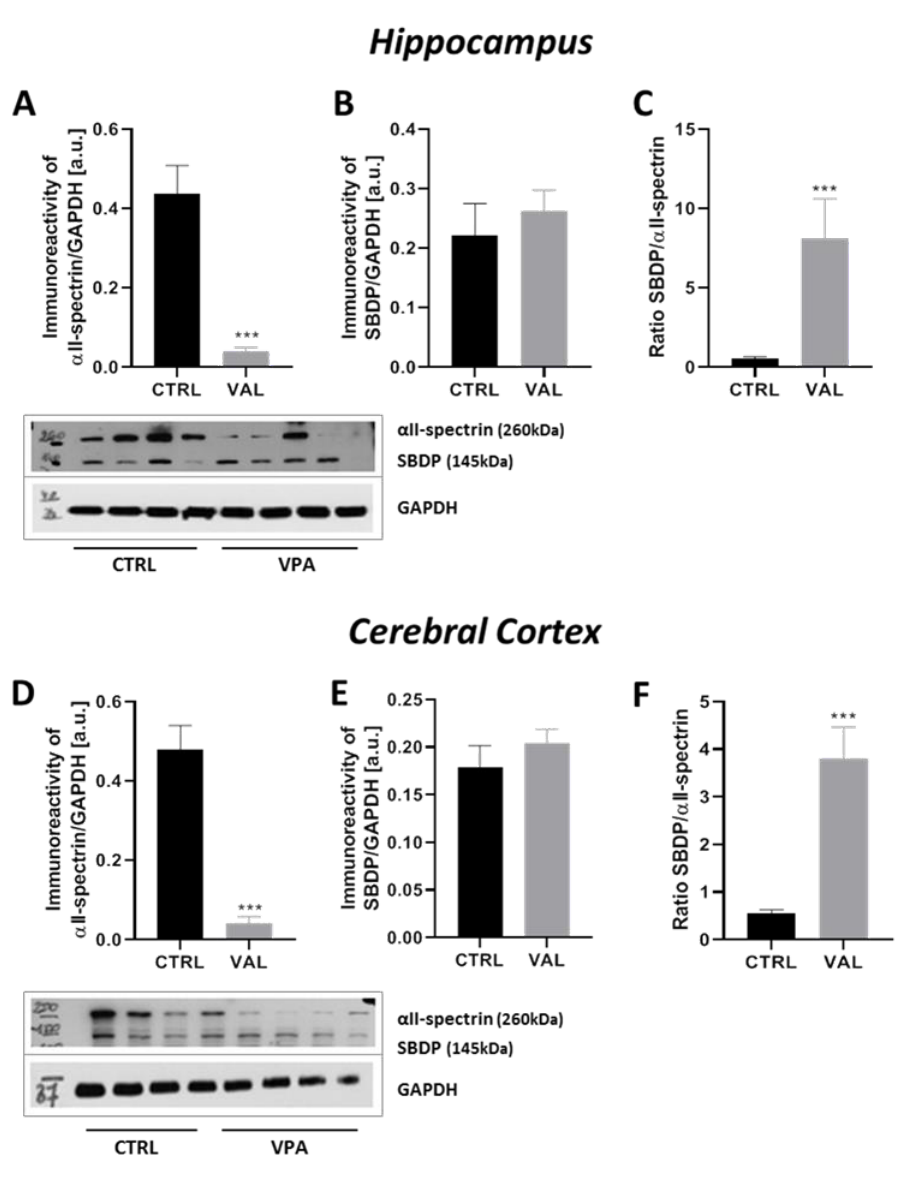
Figure 13. The effect of prenatal exposure to VPA on the calpain-dependent cleavage α II-spectrin and spectrin breakdown product (SBDP) generation in the rat brain. Immunoreactivity of α II-spectrin and its degradation product SBDP ( α II-spectrin breakdown product, 145 kDa) were determined using Western blot analysis. Densitometric analysis and representative pictures of α II-spectrin and SBDP in the hippocampus ( A , B ) and cerebral cortex ( D , E ) were shown. Results were normalized to GAPDH levels. Additionally, the ratio of SBDP/ α II-spectrin in the hippocampus ( C ) and cerebral cortex ( F ) were measured. Data represent the means ± S.E.M. from n = (7–9) independent experiments in the hippocampus: ( A ) n = 8 (CTRL), n = 8 (VPA); ( B ) n = 7 (CTRL), n = 9 (VPA); ( C ) n = 7 (CTRL), n = 7 (VPA); and n = (10–11) in the cerebral cortex: ( D ) n = 11 (CTRL), n = 10 (VPA); ( E ) n = 11